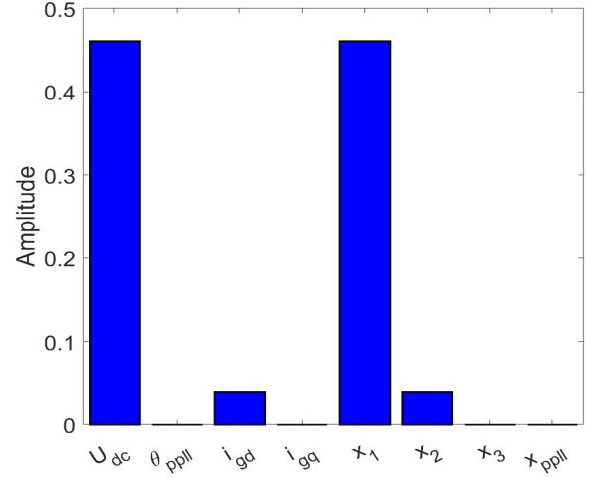
Figure 15. Participation factors of SSR modes with k ppll = 3.